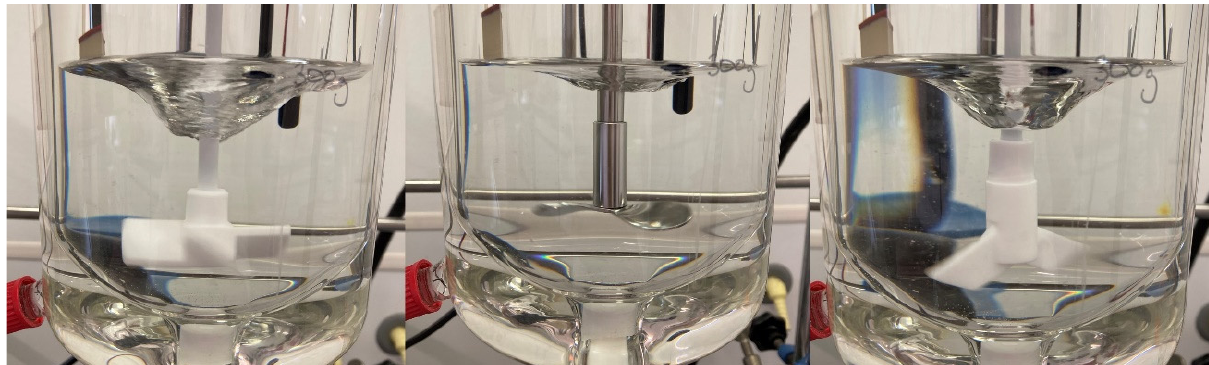
Figure 8. Vortex produced by different stirrer types at 300 rpm.